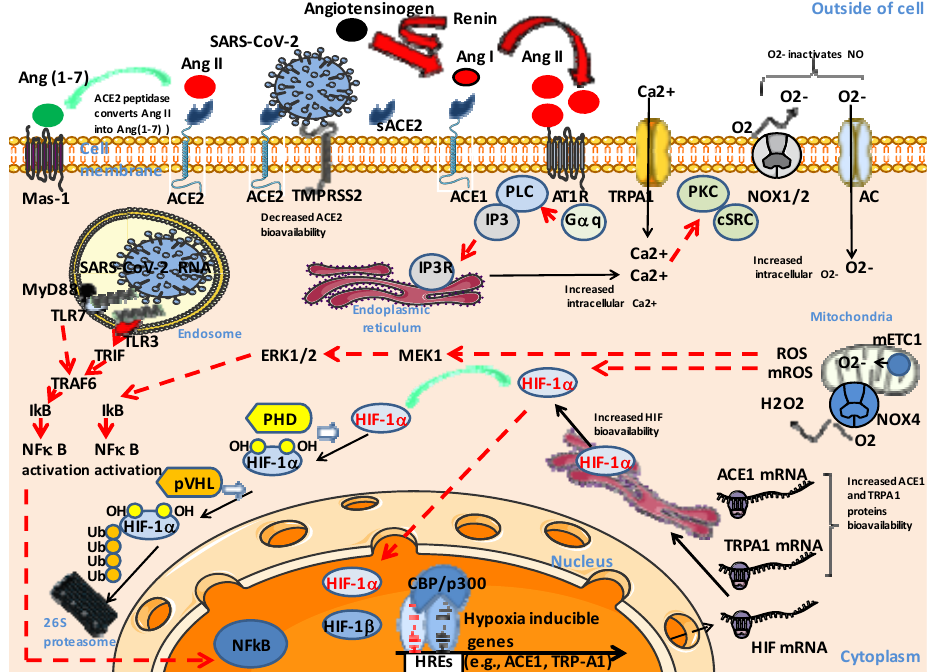
Figure 4. Proposed model of signaling in SARS ‐ CoV ‐ 2 ‐ induced silent hypoxia. In order to simplify